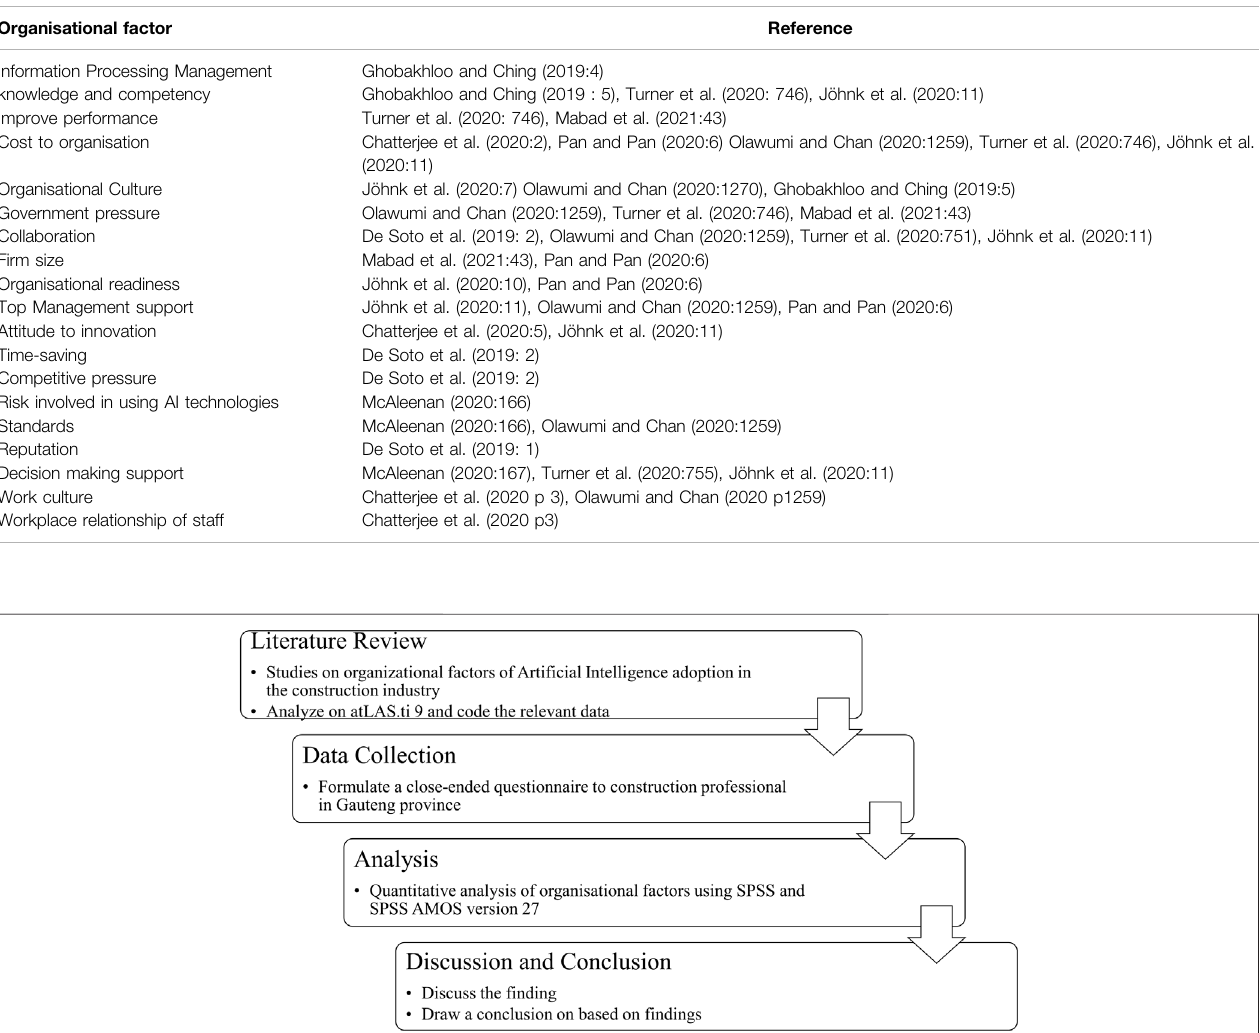
TABLE 1 | Summary of organisational factors.